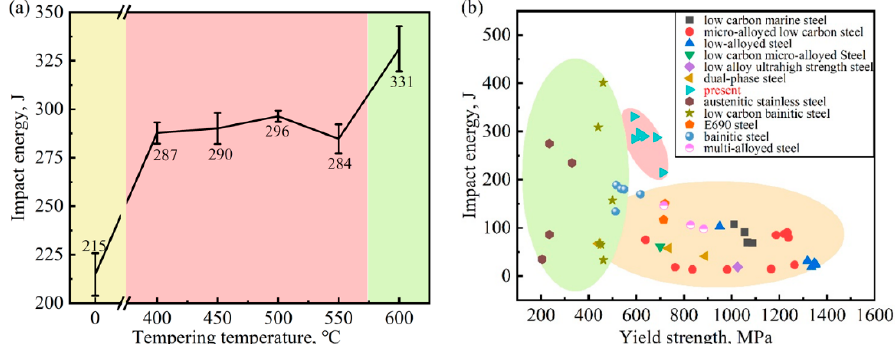
Figure 3. ( a ) Impact energy of the specimens after different heat treatments, ( b ) Mechanical property